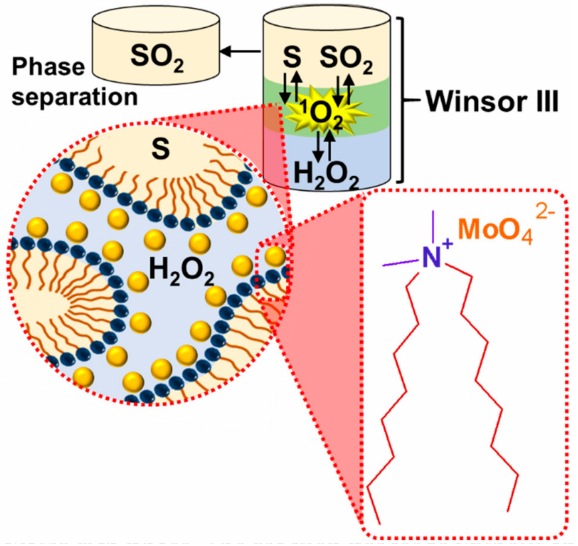
Figure 32. Oxidation in three-liquid-phase microemulsion systems using catalytic surfactants (S: substrate, and SO 2 : oxidized substrate).